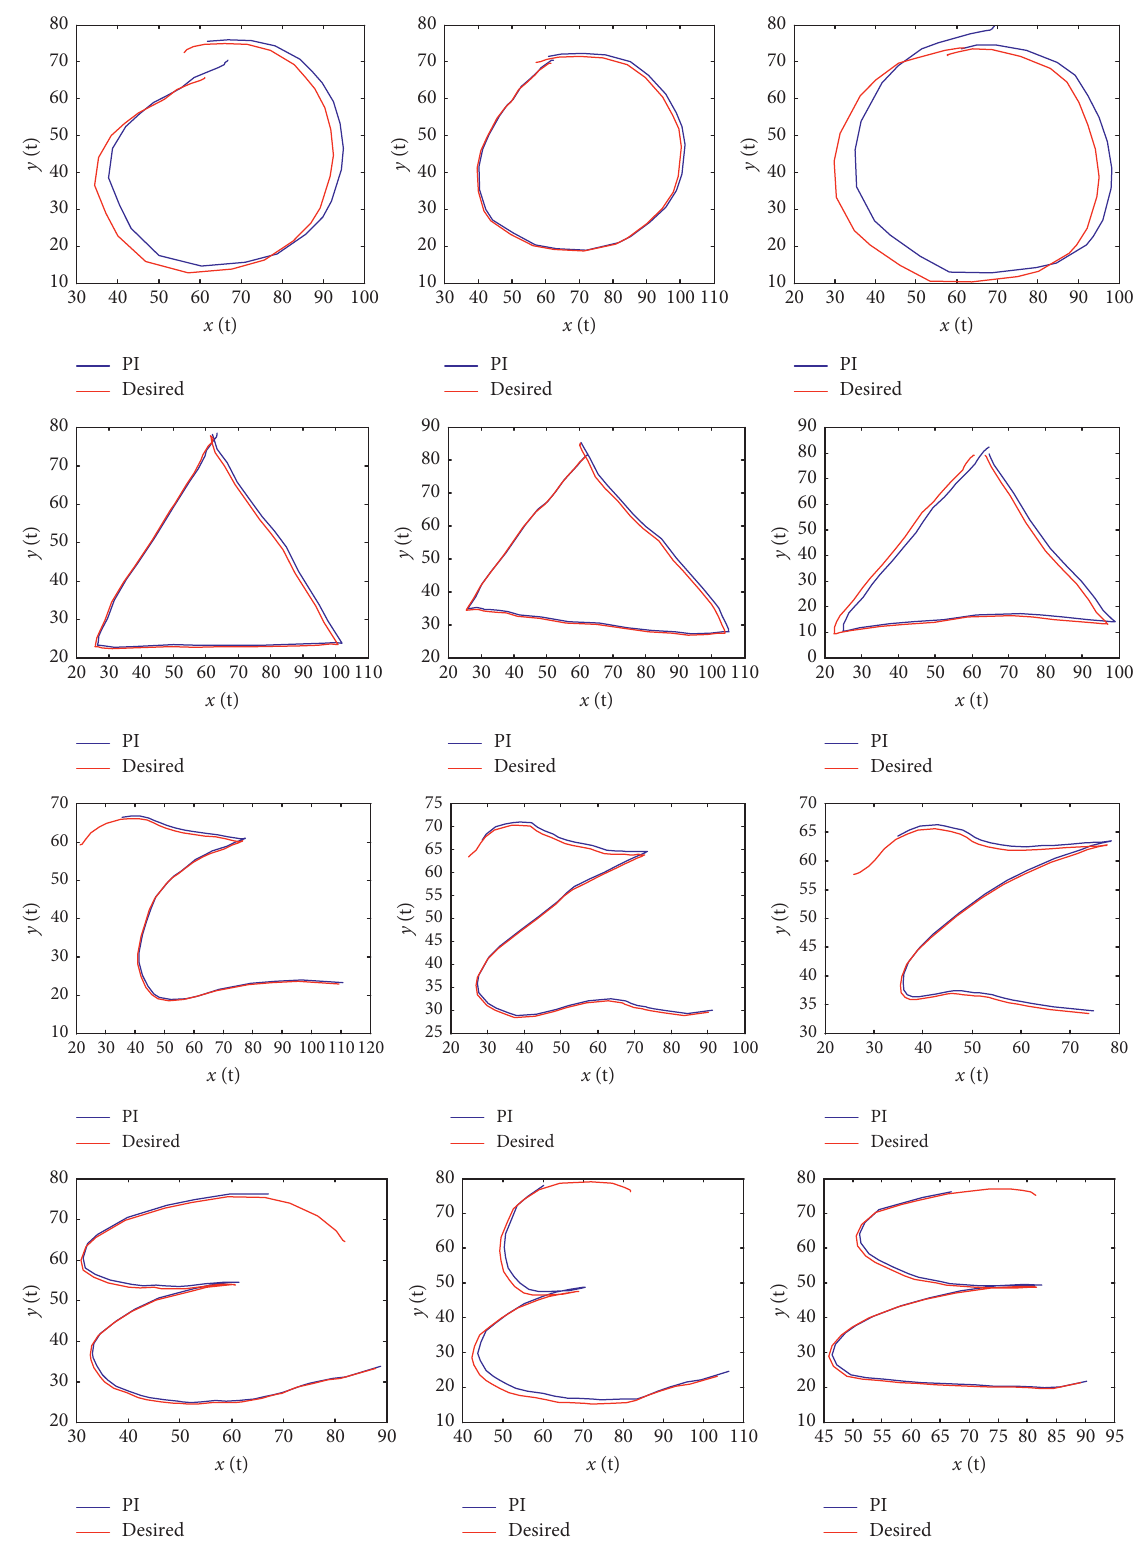
Figure 14: Validation results of the adaptive PI control for different geometric forms and Arabic